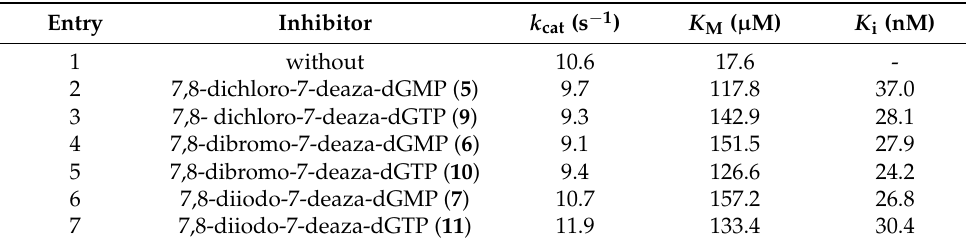
Table 2. Steady-state kinetic parameters for the MTH1 hydrolysis of 8-oxo-dGTP in the presence and absence of new 7-deaza-dG derivatives as inhibitors 1